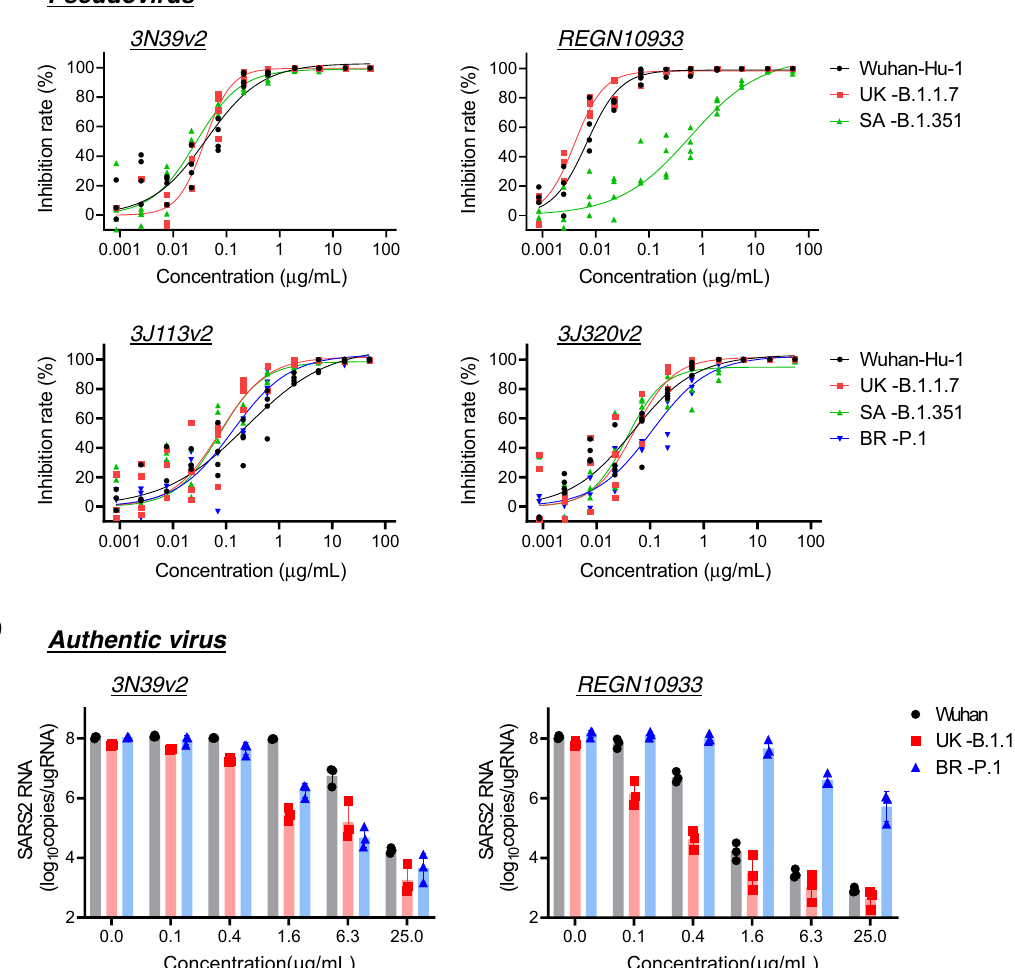
Fig. 4 Preserved neutralizing effect in 3N39v2 against globally spreading SARS-CoV-2 variants. a ACE2-Fcs and monoclonal antibody, REGN10933 46 neutralized pseudotyped variants recently emerged in the United Kingdom (B.1.1.7), South Africa (B.1.351), and Brazil (P.1) in 293T/ACE2 cells. n = 4 technical replicates. b Neutralization potency of 3N39v2-Fc and monoclonal antibody, REGN10933 against UK-B.1.1.7 and BR-P.1 was analyzed in Vero6E/ TMPRSS2 cells. Data are mean ± SEM of n = 3 technical